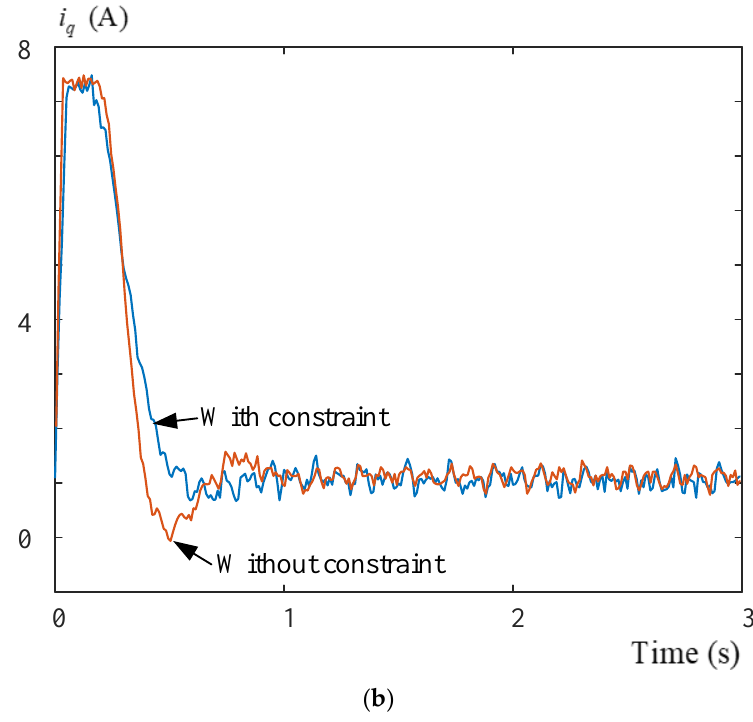
Figure 22. The measured responses at 50 r/min. ( a ) speeds, ( b ) currents.